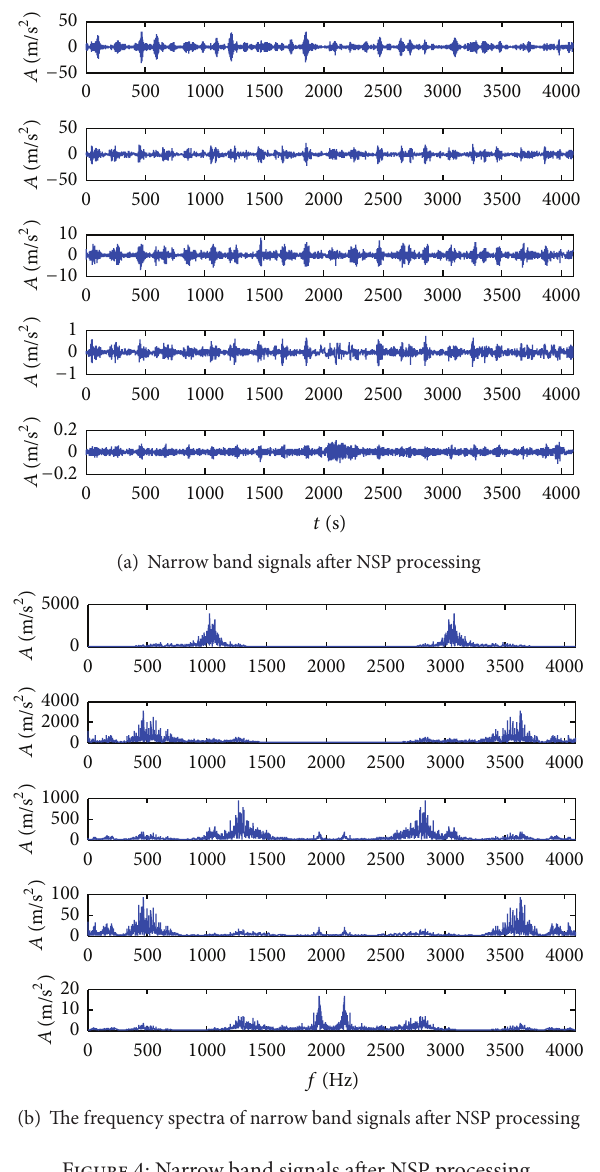
(b) The frequency spectra of narrow band signals after NSP processing Figure 4: Narrow band signals after NSP